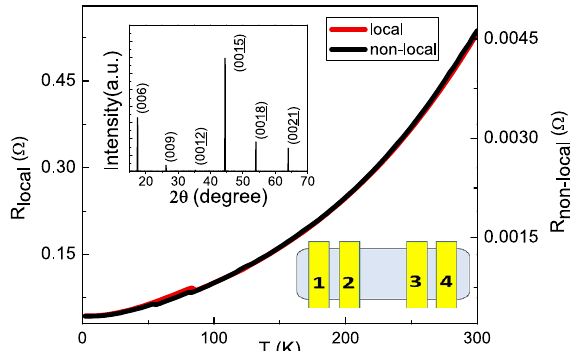
Figure 1. The top-left inset shows the XRD spectrum revealing sharp peaks testifying high quality BiSbTe 3 crystal. The bottom-right inset shows the probe configuration in this work. The applied current, I 14 , flows through the electrode 1 and 4, and the voltage difference, V 23 , is detected at the electrode 2 and 3 in the